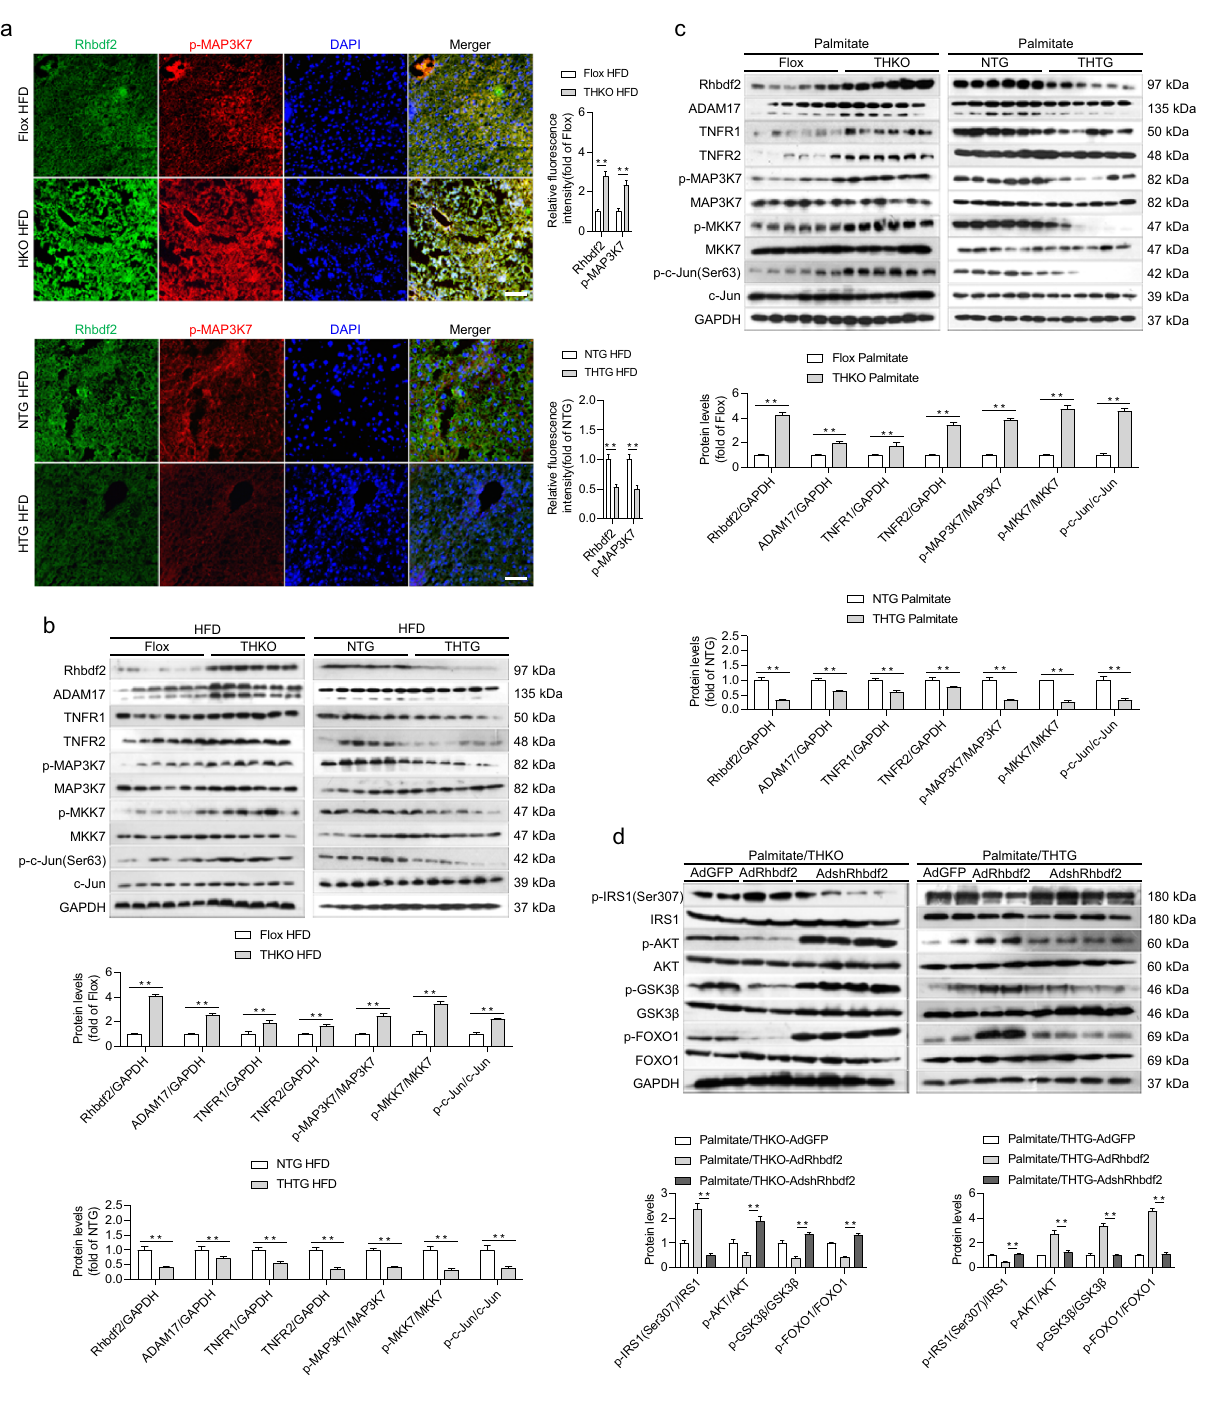
globulin (TBG) harboring Trim31 with a RING- fi nger domain mutant (AAV-Trim31 RING Δ ) was accordingly generated and injected into the 6-week HFD-fed preconditioned WT mice in parallel with AAV-Trim31. The mice injected with AAV-GFP were treated as controls (Supplementary Fig. S14a). Undoubtedly, AAV- Trim31 RING Δ lost the ability to affect body weight, blood glucose levels, blood insulin levels, liver weight, LW/BW ratio, AST, ALT, and AKP levels, pathological phenotype, and hepatic TG, TC, and NEFA levels, while AAV-Trim31 did not (Supplementary Fig. S14b – f). Meanwhile, consistent with the ex vivo data as indi- cated in Supplementary Fig. S11, mice with AAV-Trim31 RING